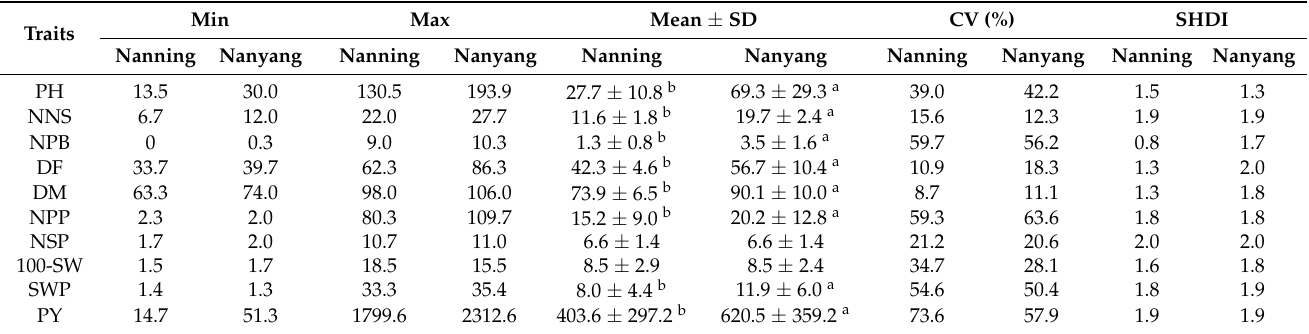
Table 1. The phenotype of 10 traits of adzuki beans in two locations.